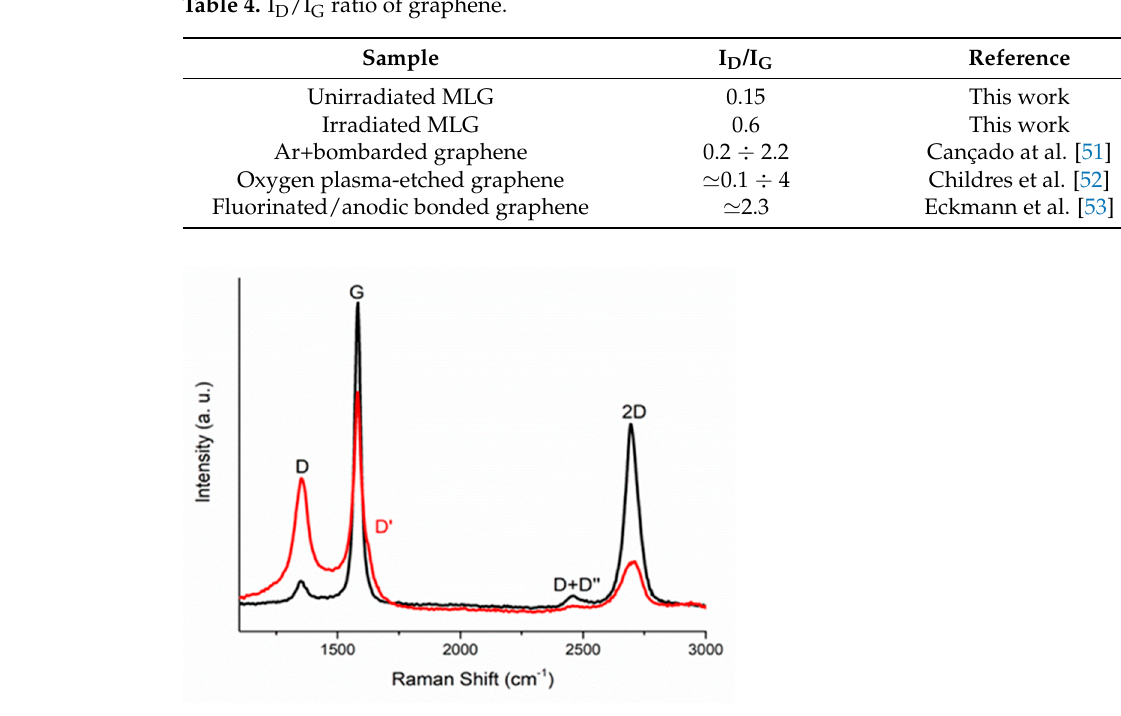
Table 4. I D /I G ratio of graphene.